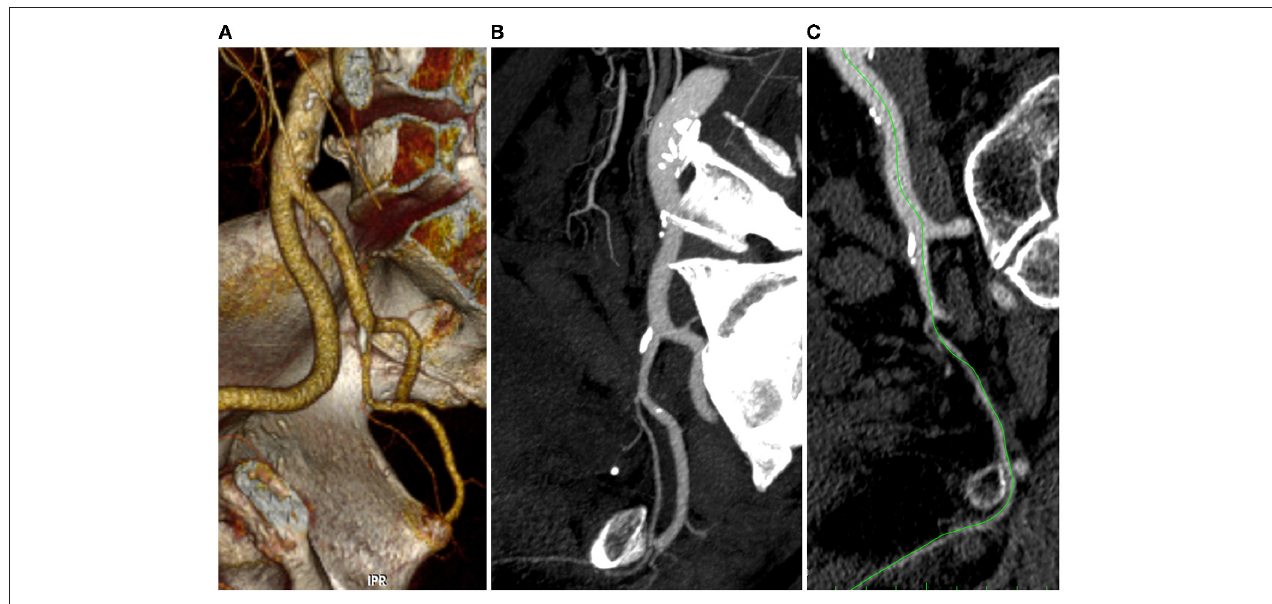
FIGURE 1 | 3D volume rendering (A) , multi-planar (B) , and center lumen line (C) reconstruction of the iliac-pelvic district (Anatomical Score